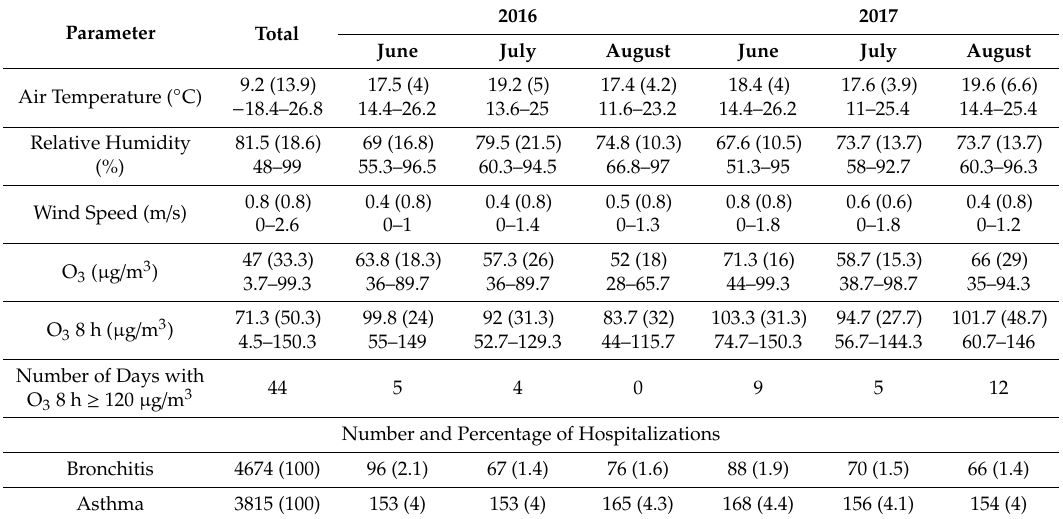
Table 1. Meteorological conditions and ozone concentrations, and number of hospitalizations due to asthma and bronchitis in the summer months, the central area of the agglomeration—CAA 2016–2017.